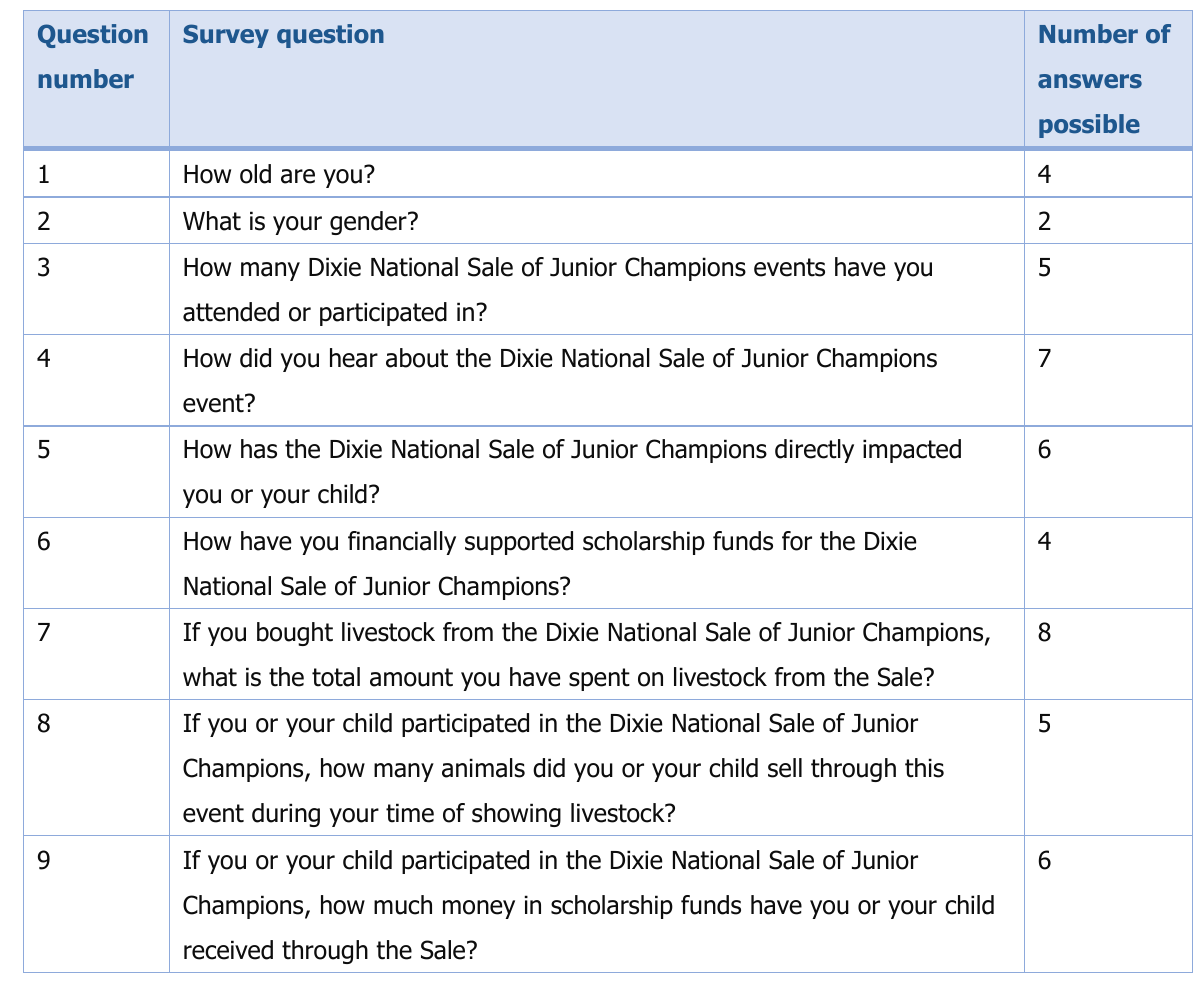
Table 1. Questions From the 2018 Sale of Junior Champions Survey